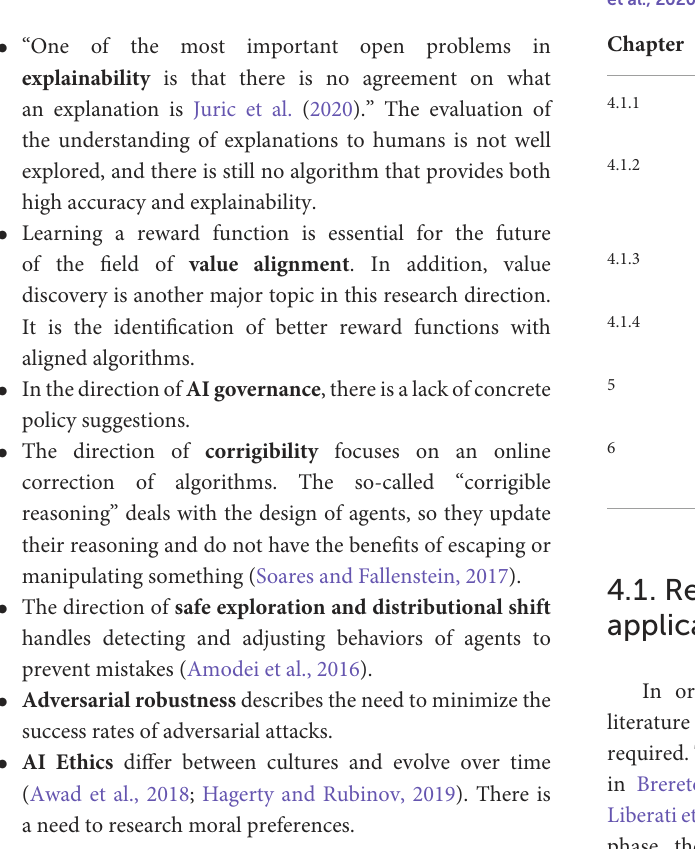
TABLE 2 Methodology for the systematic literature review (adapted of Brereton et al., 2007; Kitchenham and Charters, 2007;